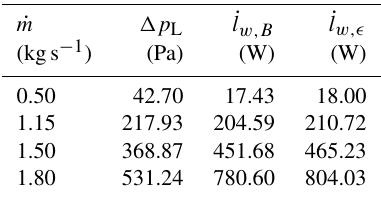
Table 2. Energy balance check for simulations relative to the stan- dard geometry cone.